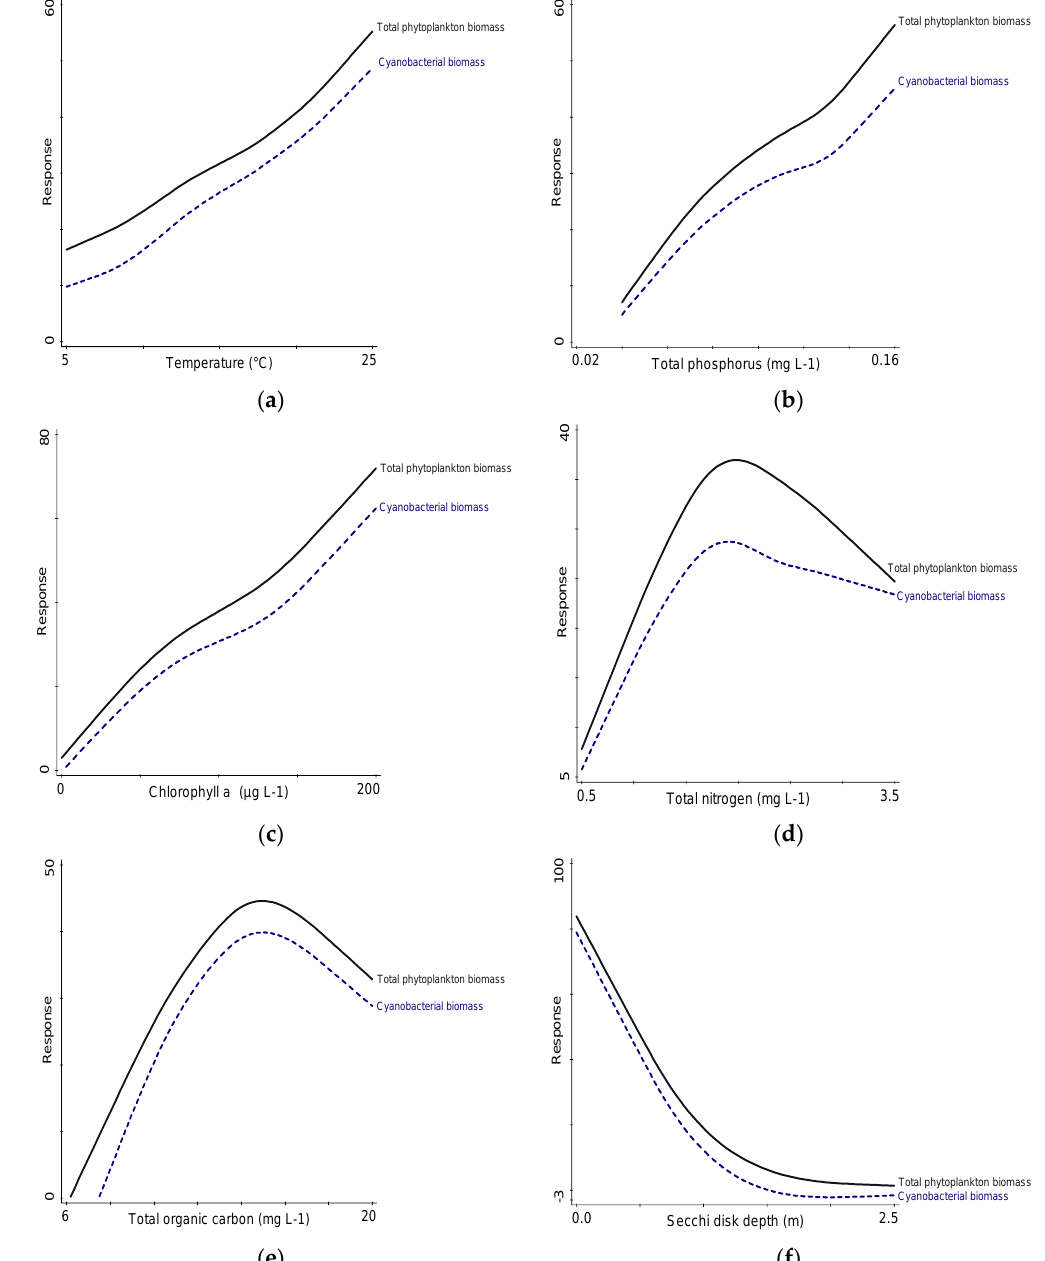
Figure 7. The GAM-based response of the total phytoplankton and cyanobacteria biomasses to water temperature ( a ), total phosphorus ( b ), chlorophyll a ( c ), total nitrogen ( d ), total organic carbon, ( e ) and Secchi disk depth ( f ).